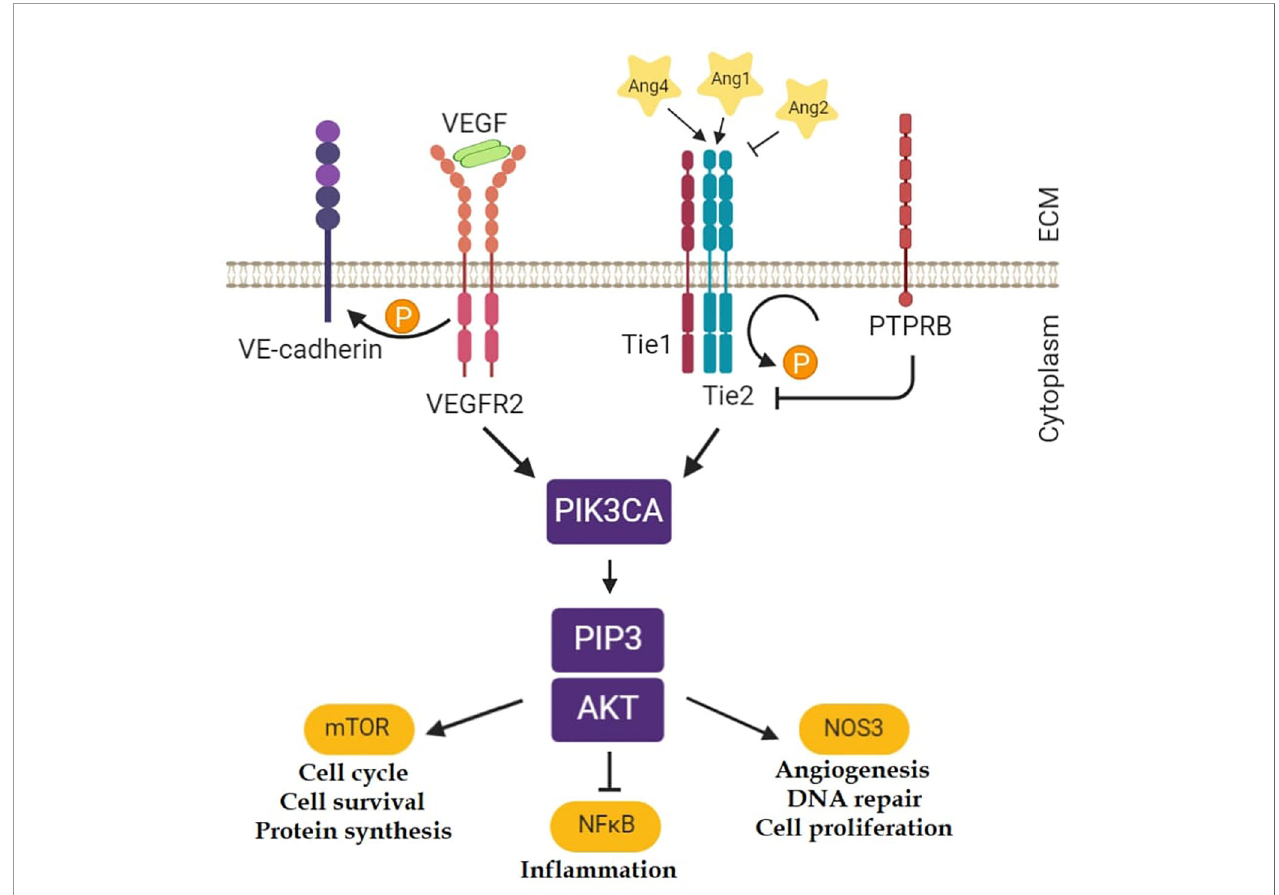
FIGURE 1 | Tie2 related pathways (Karar and Maity, 2011). Ten genes were selected from these pathways for the gene expression analyses in the mouse model of asthma: Angpt1; Angpt2; Angpt4; Tek; Nfkb1; Kdr (gene for Vegfr2); Pik3ca; Akt1; Nos3; Ptprb . (The fi gure was created with